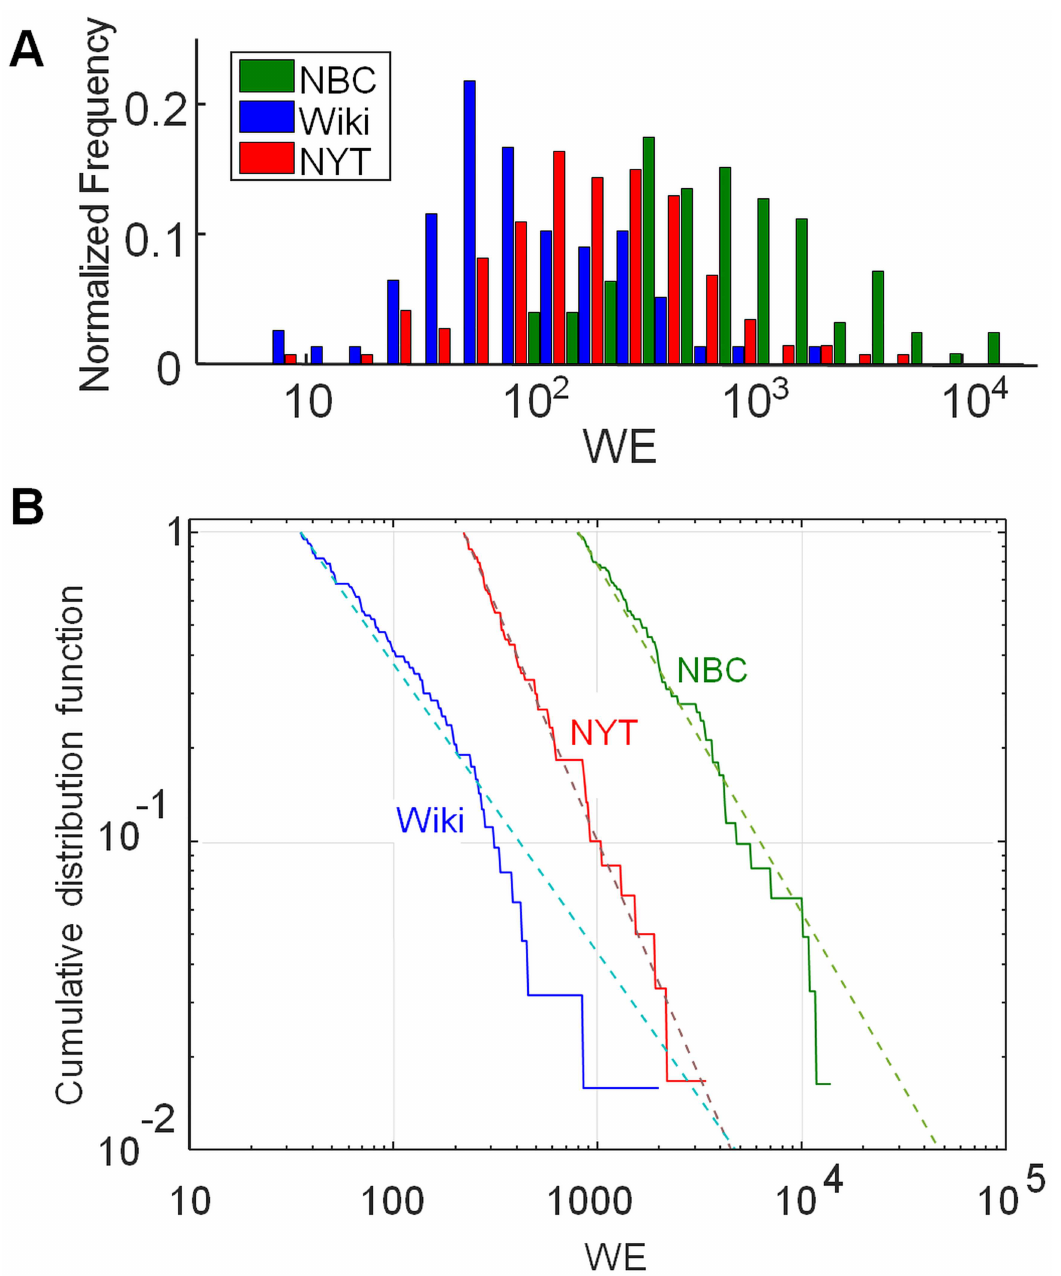
Fig 5. Probability distributions for fame. Probability distributions for fame, as measured by WE , for individuals in the NBC, Wiki, and NYT (1 & 2) datasets. (A) Histogram showing, for each dataset, the distribution of reported deaths with respect to WE . (B) Cumulative distribution functions (CDF) with respect to WE are shown as the solid curves. CDF are evaluated using cutoff WE values of 35 (Wiki), 220 (NYT) and 800 (NBC). For each dataset, the optimal value of the power law exponent and cutoff ( α and x min respectively in Eq 4) were evaluated as described in Methods [24], with results shown in Table 2. The dashed lines show the CDF for true power law distributions that have the same α and x as the min